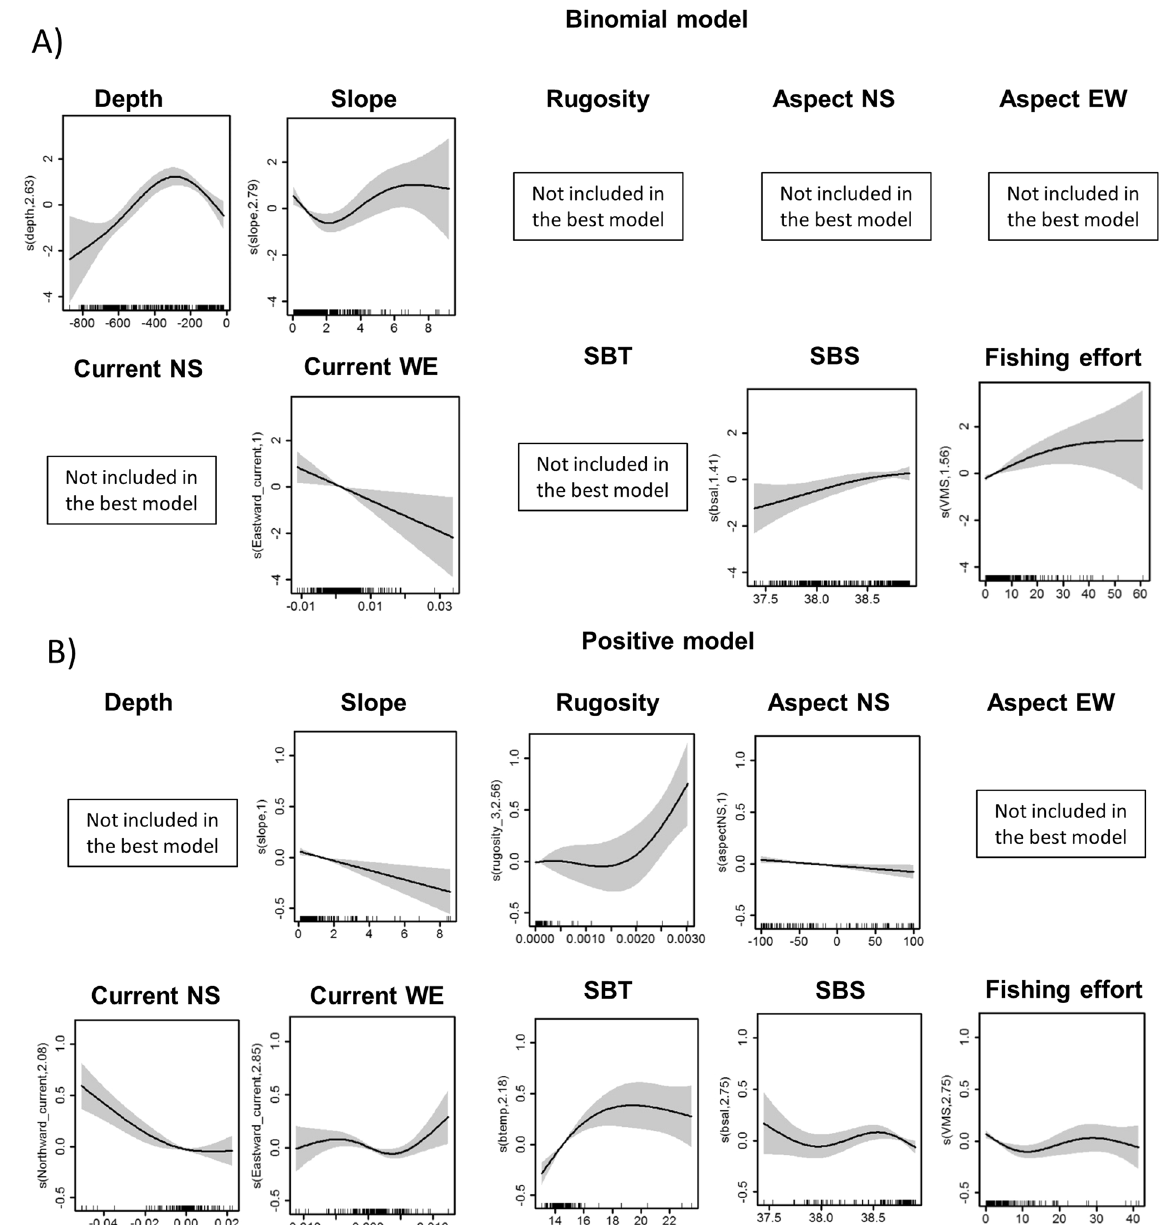
Figure 3. Partial GAM plots for the best binomial and positive models for Funiculina quadrangularis . Each plot represents the response variable shape, independent of the other variables, in relation to the probability of the species occurrence ( A ) and abundance ( B ) in the multivariate model. The ranges of environmental variables are represented on the x-axis and the probability of occurrence of the species is represented on the y-axis (logit scale). The zero value indicates mean model estimates, while the y-axis is a relative scale where the effect of different values of the predictors on the response variable is shown. The degree of smoothing is indicated in the y-axis label. Confidence intervals (95%) around the response curve are shaded in